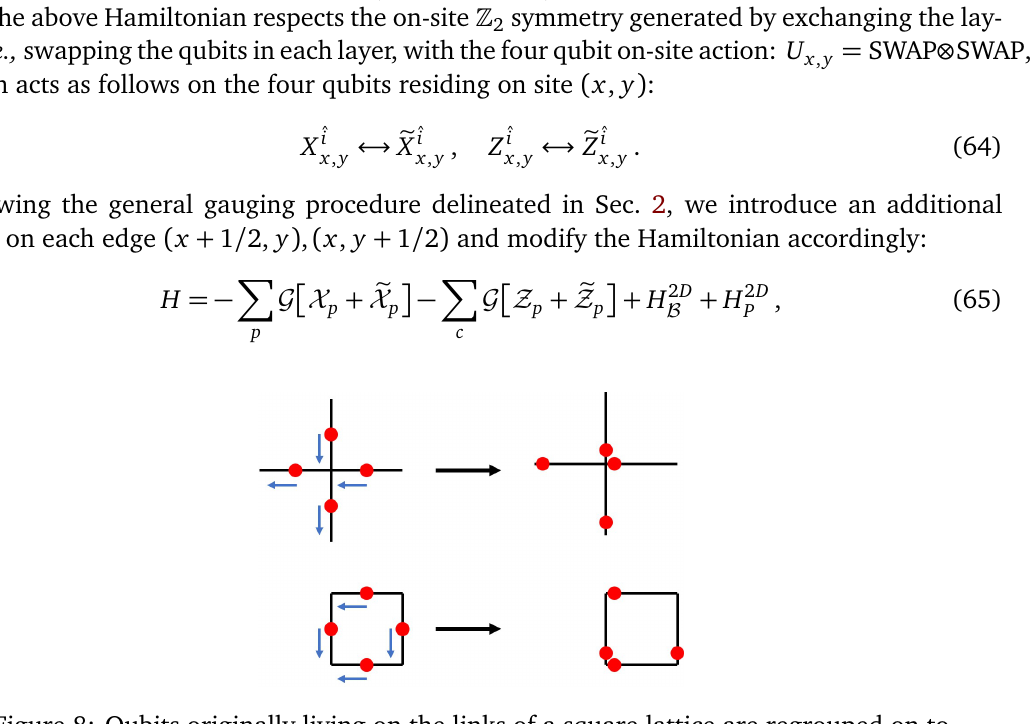
Figure 8: Qubits originally living on the links of a square lattice are regrouped on to vertices as shown